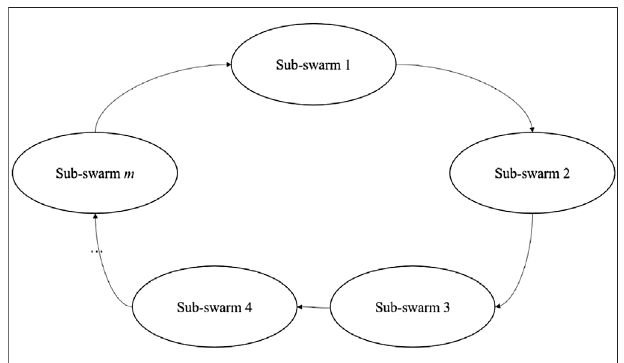
FIGURE 2 | Sequence of information transfer among